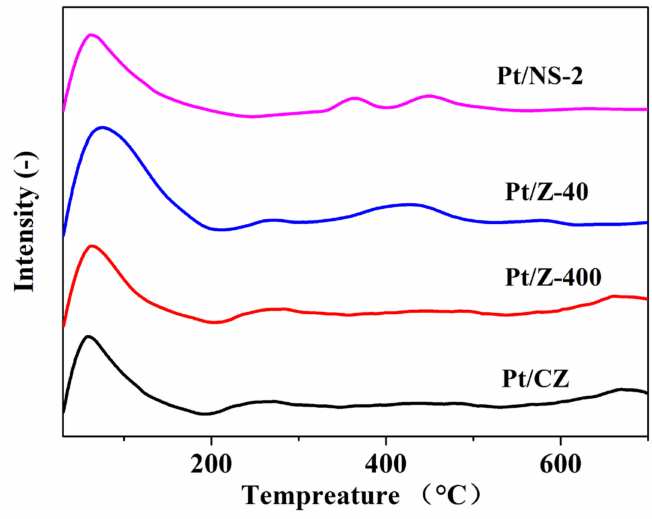
Figure 6. H 2 –TPR profiles of the Pt-loaded zeolite catalysts.